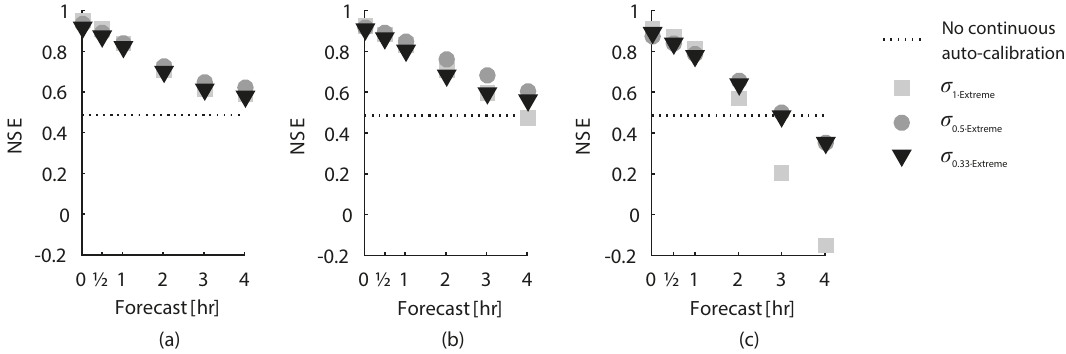
Figure 7. Forecast performance for different σ -scenarios with a fixed length of the auto-calibration period; ( a ) 8 h; ( b ) 12 h; ( c ) 16 h.